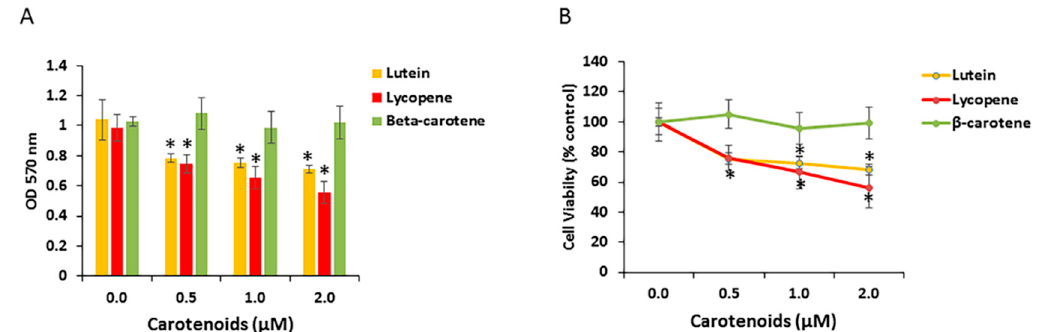
Figure 4. Effects of carotenoids on cell growth in ARPE-19. ( A ) Lutein and lycopene, but not beta-carotene, inhibited cell growth in undifferentiated APRE-19 cells. ARPE-19 cells were treated with indicated concentrations of carotenoids (0.5–2 µ M) for 48 h. Cell viability was measured by MTT assay. Data are shown as means ± SD of three different experiments ( n = 3). *, p < 0.05. ( B ) Inhibition of ARPE-19 cell growth in the presence of indicated concentration of carotenoids. Cell viability was expressed as percentage of control. Data are shown as means ± SD of three different experiments ( n = 3). *, p < 0.05.